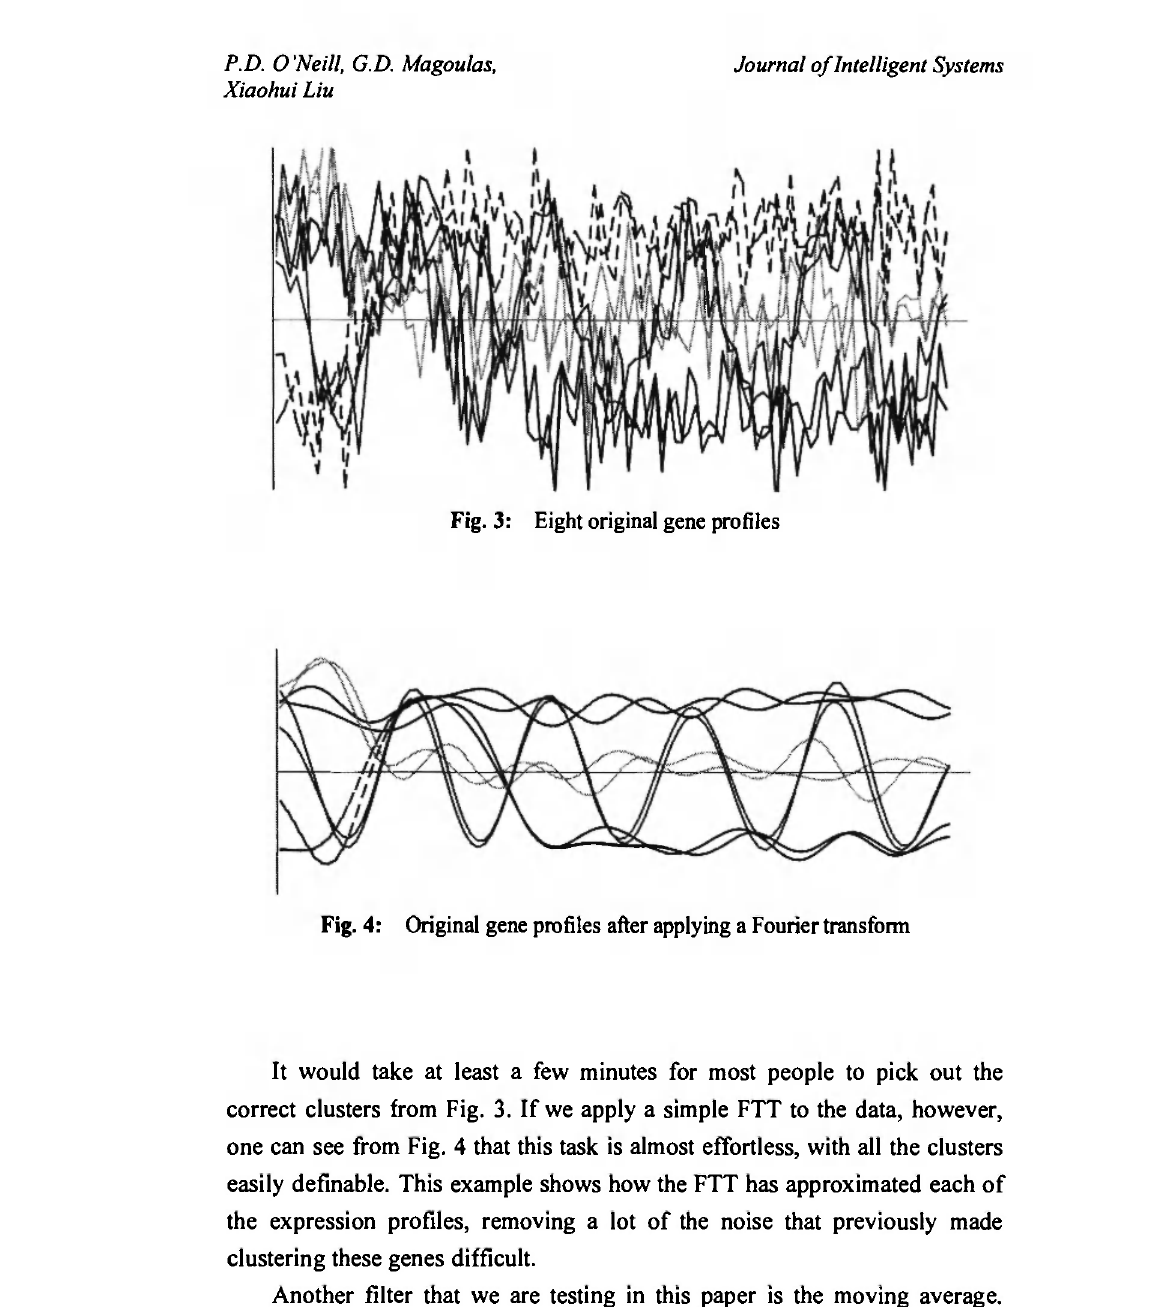
Fig. 4: Original gene profiles after applying a Fourier